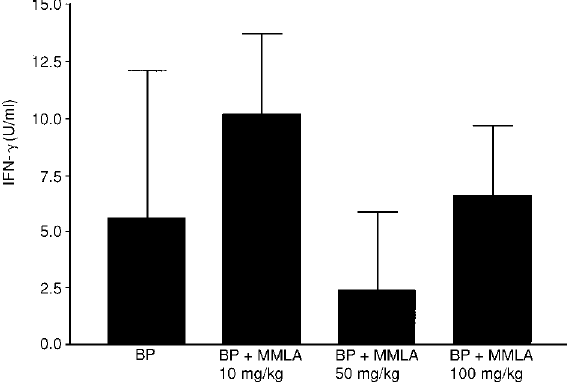
FIG. 4. Levels of IFN- g in the BAL fluid of mice infected with B. pertussis , and treated with MMLA, at various concentra- tions in a single dose intraperitoneally. Mice were sacrificed 10 days after